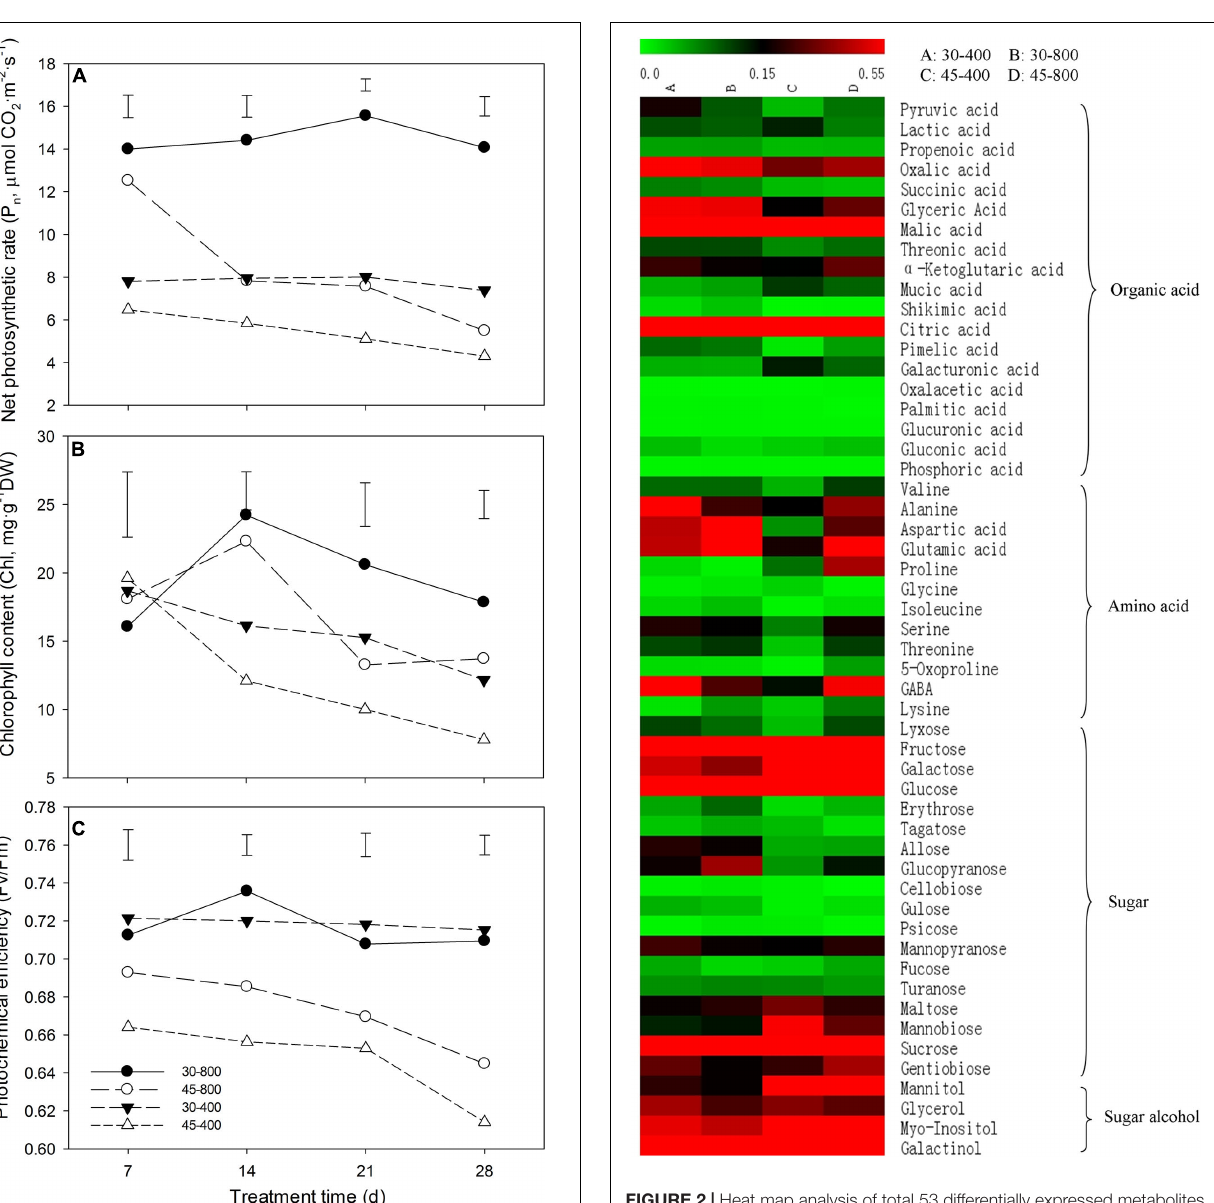
FIGURE 2 | Heat map analysis of total 53 differentially expressed metabolites in response to different temperatures and CO 2 concentrations. The treatments symbols are 30 and 45 for normal temperature control and heat stress and 400 and 800 for ambient CO 2 and elevated CO 2 concentrations,